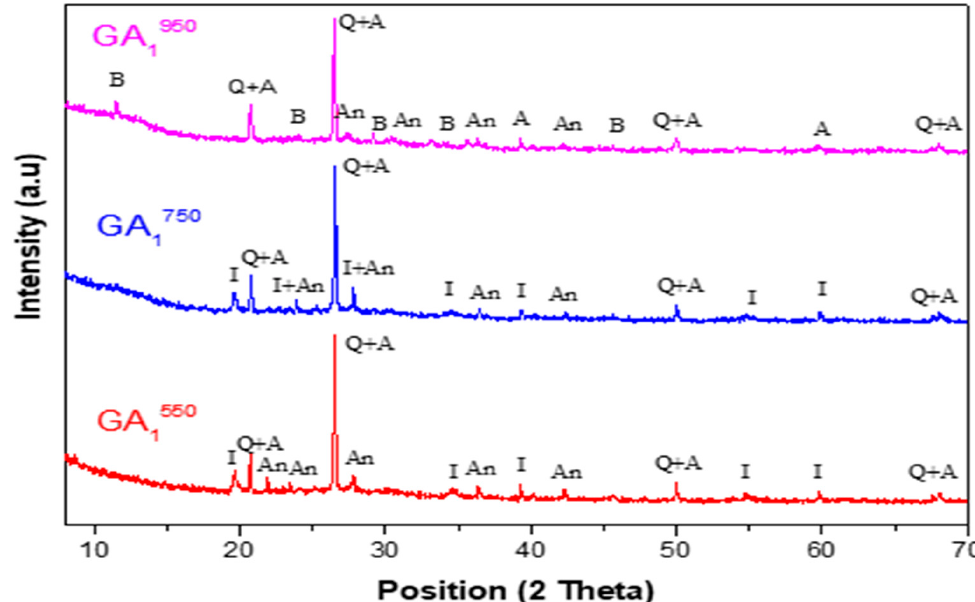
Figure 11. Diffractograms of geopolymers synthesized from Tunisian clay calcined at different temperatures (GA 1550 , GA 1750 , GA 1950 ) aged 7 days.